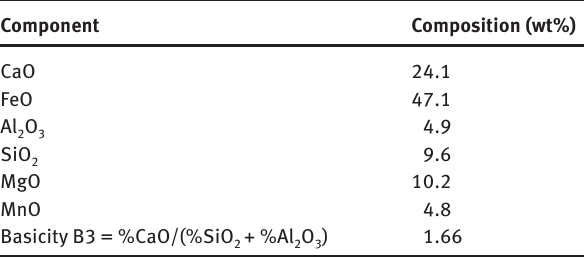
Table 3: Composition of EAF slag